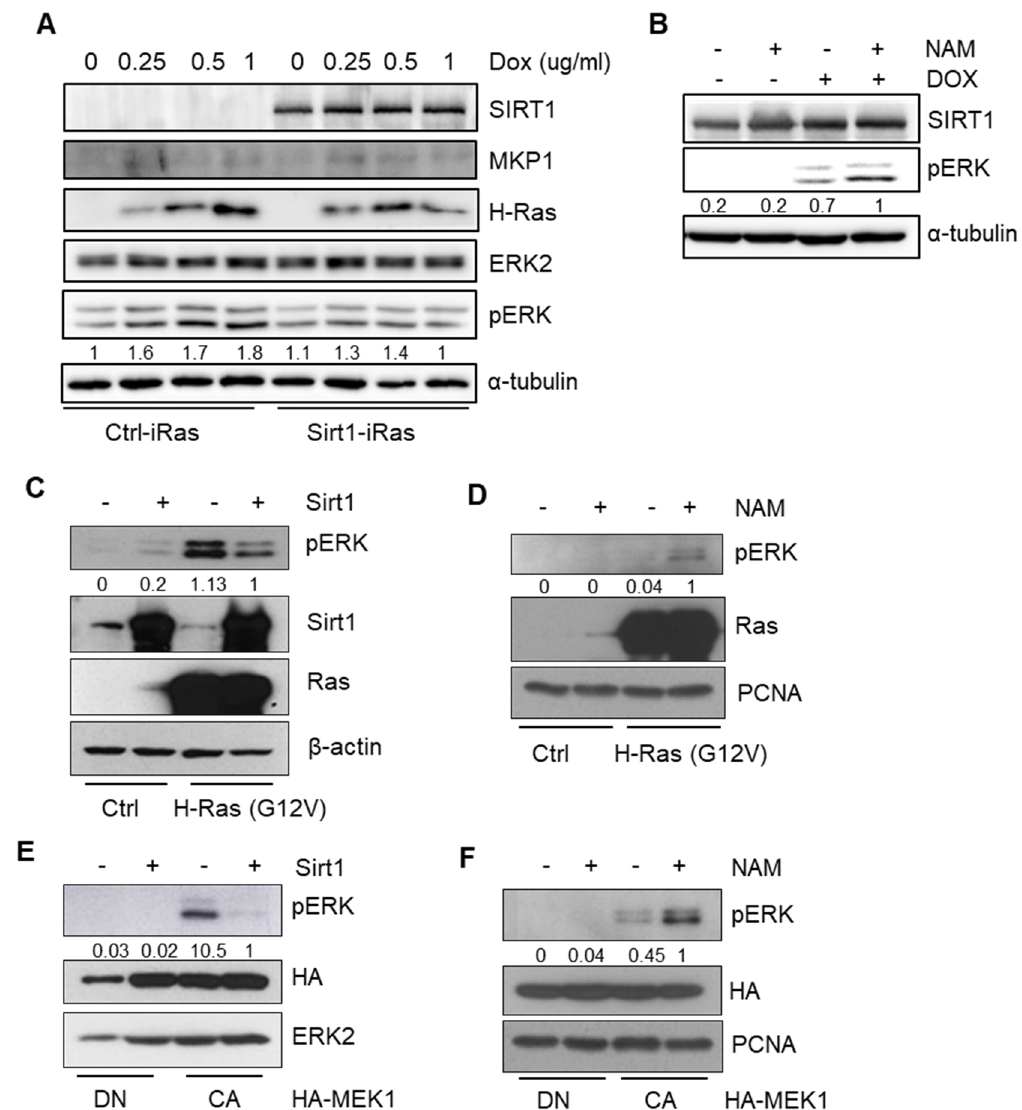
Figure 3. SIRT1 impairs RAS-mitogen-activated protein kinase (MAPK) / extracellular signal-regulated kinase (ERK) kinase (MEK)-ERK signaling. ( A ) Immunoblotting (IB) analysis shows phospho-ERK levels in Ctrl-iRas and Sirt1-iRas NIH3T3 cells. The cells were treated with Dox for 24 h at the indicated concentration. α -tubulin, a protein loading control for IB. ( B ) IB analysis of phospho-ERK in Sirt1-iRas NIH3T3 cells treated with or without nicotinamide (NAM) and Dox for 24 h. ( C , D ) IB reveals phospho-ERK levels after transfection with HRAS in the 293T cells depending on Sirt1 expression ( C ) or NAM treatment ( D ). β -actin and proliferating cell nuclear antigen (PCNA), protein loading controls for IB. ( E , F ) IB shows phospho-ERK levels after transfection with dominant negative (DN) or constitutively active (CA) MEK1 in the 293T cells depending on Sirt1 expression ( E ) or NAM treatment ( F ). ERK2 and PCNA, protein loading controls for IB. The whole western blot images please find in Figure S7.